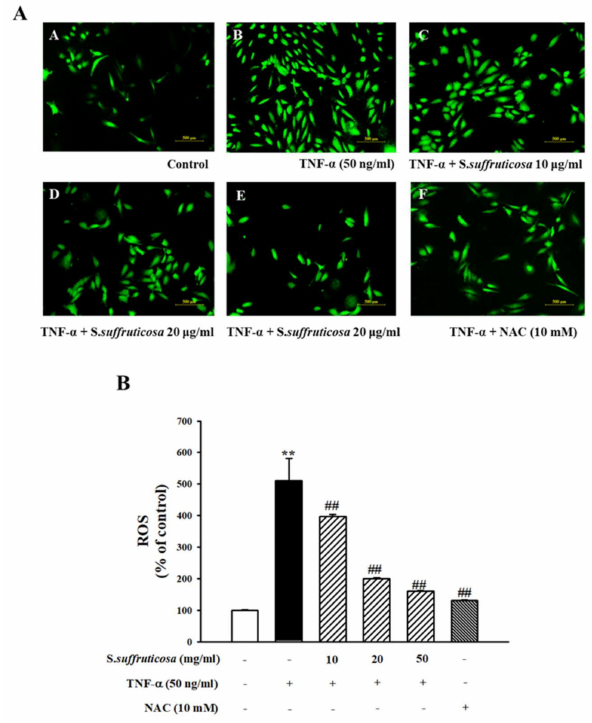
Figure 7. Inhibitory e ff ect of Securinega su ff ruticosa on TNF- α -induced reactive oxygen species